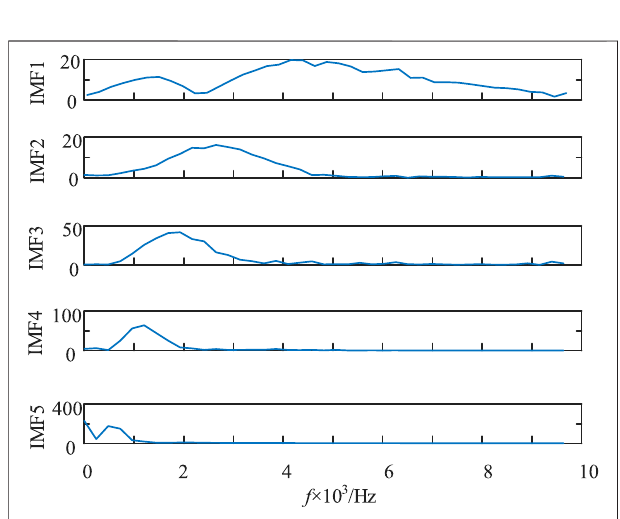
FIGURE 11 | Frequency spectrum of CEEMDAN modal